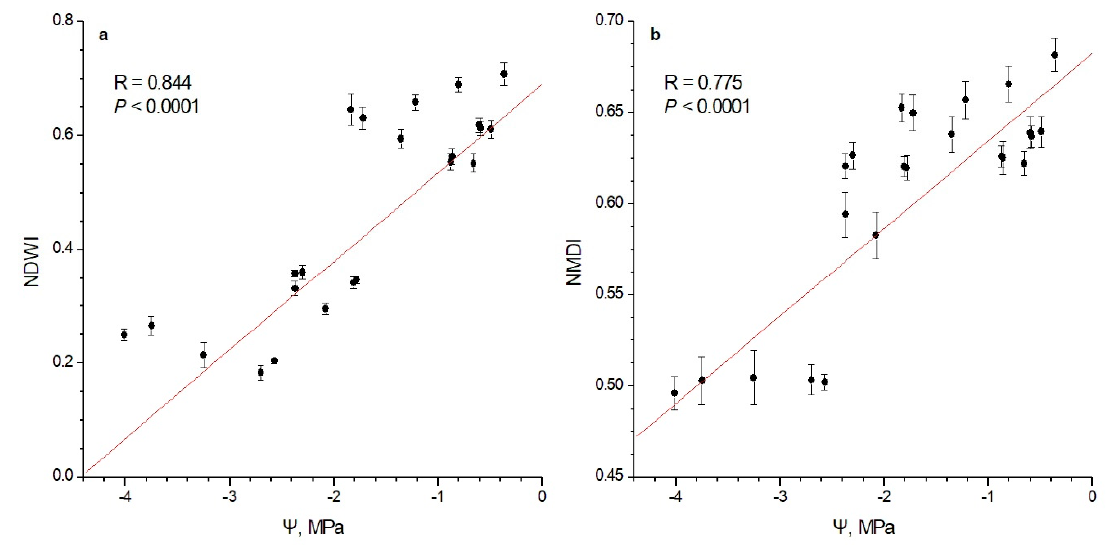
Figure 9. Relationships between water potential ( Ψ ) and Sentinel-2 water indices NDWI ( a ) and NMDI ( b ). Data concern dates with both Sentinel-2 acquisitions and field measurements. Each point corresponds to one Ψ measurement performed in one plot at one date and the mean from the corresponding 9 Sentinel-2 pixels ± standard